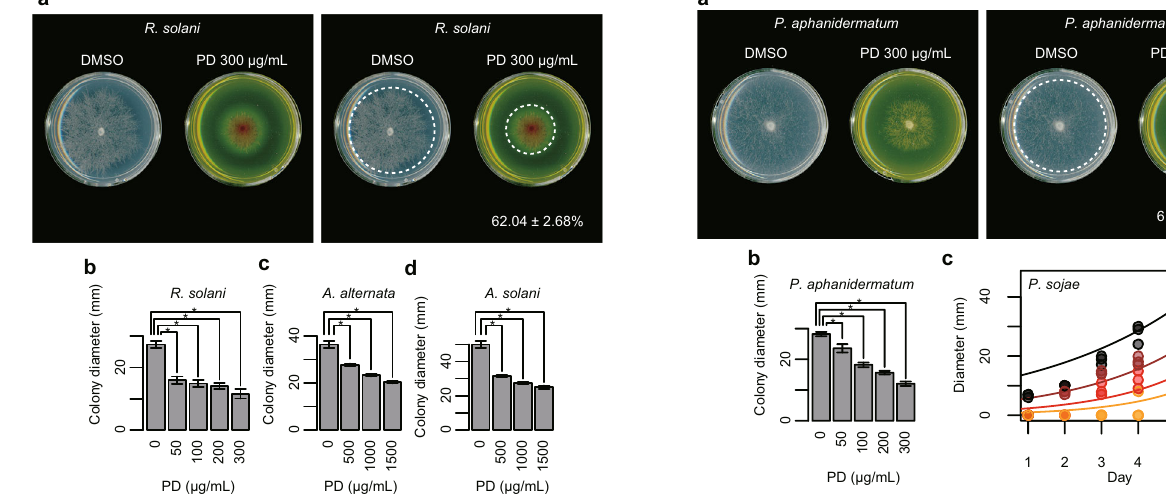
Fig. 8 Sensitivity of phytopathogenic fi lamentous fungi to poacidiene. a The effects of poacidiene (PD) on the growth of the fi lamentous fungi R. solani at 300 µg/mL. The radial growth of mycelia was tested ( n = 3) after 24 h, and PDA plates containing DMSO were used as control plates. The percentage and ± standard error of the growth inhibition by PD ( n = 3) were estimated by maximum likelihood estimation of one-way ANOVA assuming gamma distribution to colony diameter (mm) compared with the growth on the control plates ( n = 3). The images with and without a dotted circumference are shown after enhancing the contrast. The raw images are shown in Supplementary Fig. 5. The dotted circle indicates the edge of the colony. The dose-dependent inhibition of b R. solani after 24 h, c A. alternata after 120 h, and d A. solani after 120 h by PD. The radial growth of mycelia was tested ( n = 3). Asterisks indicate a signi fi cant difference at p < 0.01 by Dunnett ’ s test. Error bars in the bar plots indicate standard